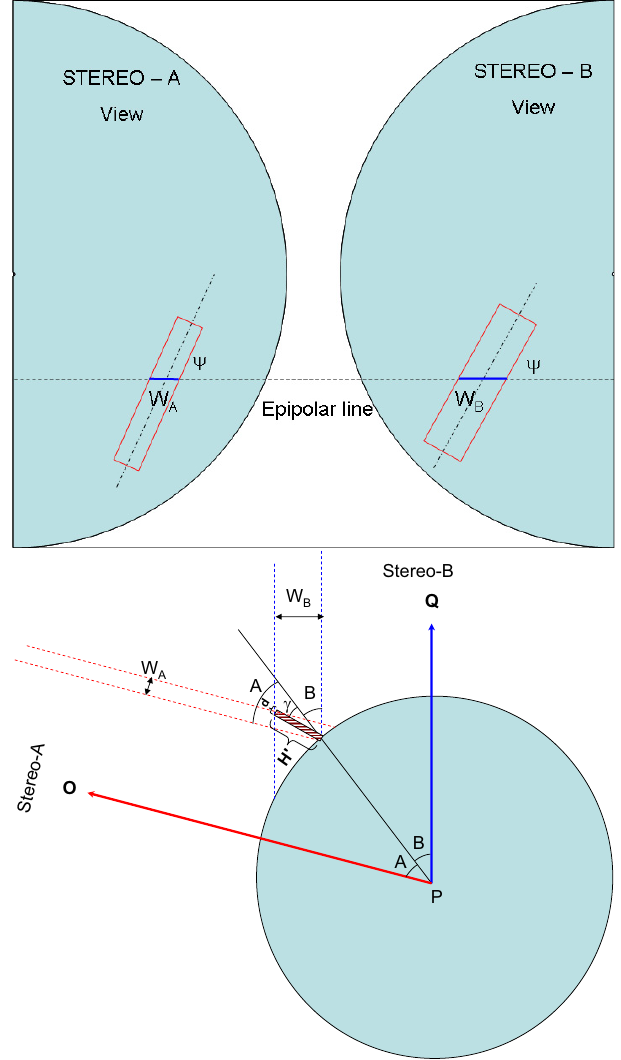
Fig. 1. Top panel (epipolar plane view): The two views of the sun from STEREO-A,B are illustrated with filament-axis at an arbitrary orientation 9 to epipolar plane. The projected width of the filament measured along epipolar line is W A and W B . Bottom panel (Cross- sectional view): The blue circle represents cross-section of the sun along a vertical plane through epipolar line drawn in top panel. The Sun, STEREO-A, B satellites along with a cross-section of the fila- ment along W A and W B are shown. The segment H 0 represents the intersection of filament sheet and epipolar plane. Since filament is oriented at an angle 9 the width of the filament sheet is determined by H = H 0 sin 9 . For 9 = 90 ◦ we will have H = H 0 . The filament sheet is inclined at an angle γ to the local solar vertical. The angles A and B are heliocentric angles of the filament base in the reference frames of STEREO-A,B respectively. P is the central point of this solar